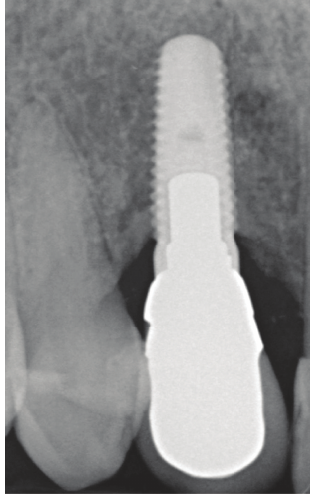
Figure 22: Three-year periapical X-ray. The implant appeared well integrated and the mesial and distal bone levels showed a physiological